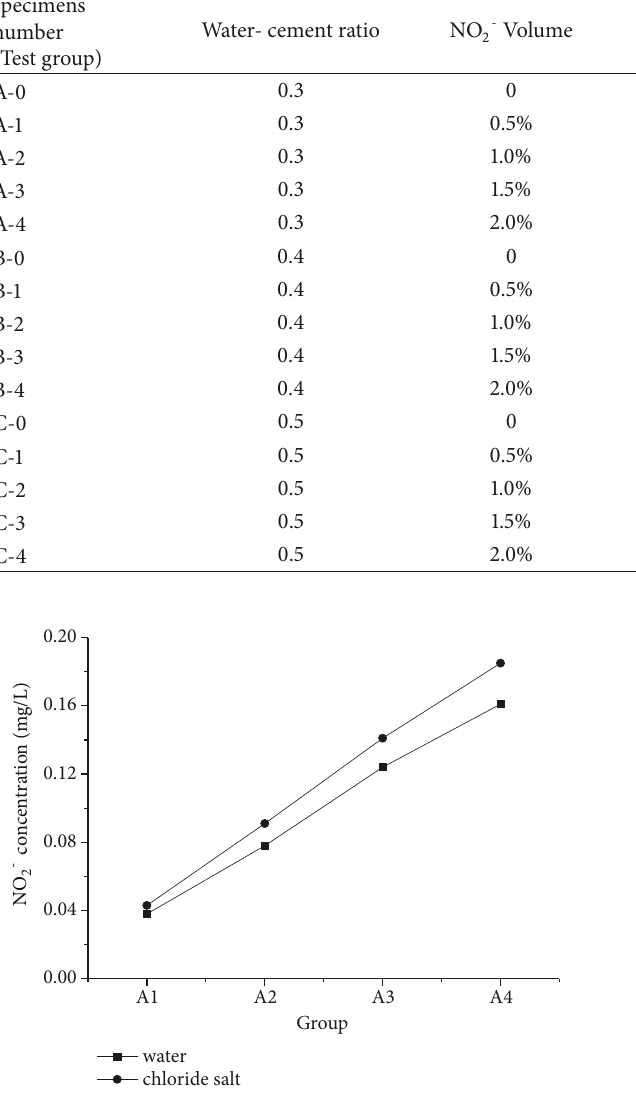
Figure 1: Concentration comparison of free-form NO 2 - .